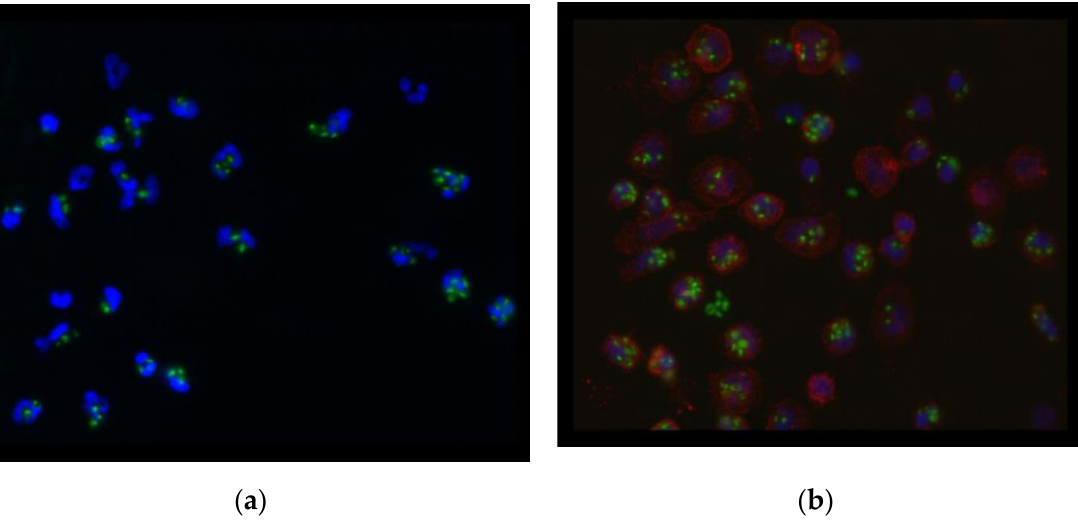
Figure 1. Fluorescence microscopic view (blue: nucleus of cells, green: Zymosan particles, red: cell membrane of monocytes) of neutrophil granulocytes ( a ) and monocytes ( b ) with phagocyted zymosan particles.